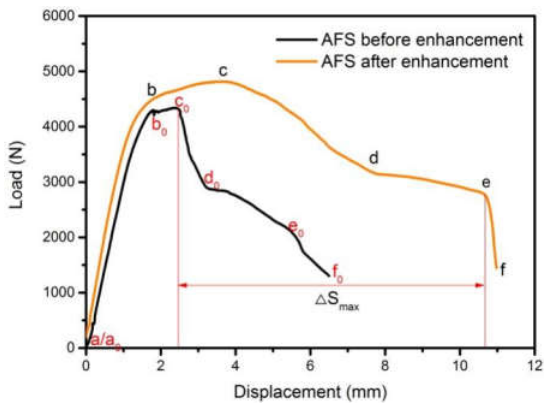
Figure 8. Load-displacement curves of AFS before and after interface enhancement.